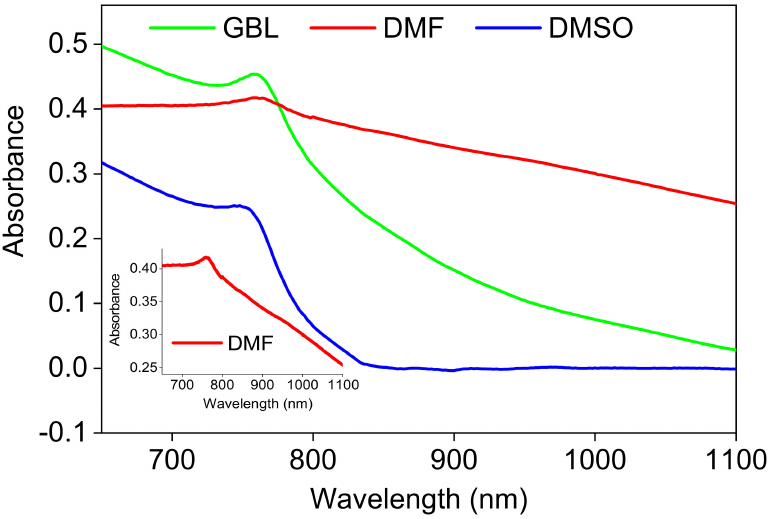
Figure 4. Absorbance spectra of the MAPbI 3 perovskite thin films made in various solvents.